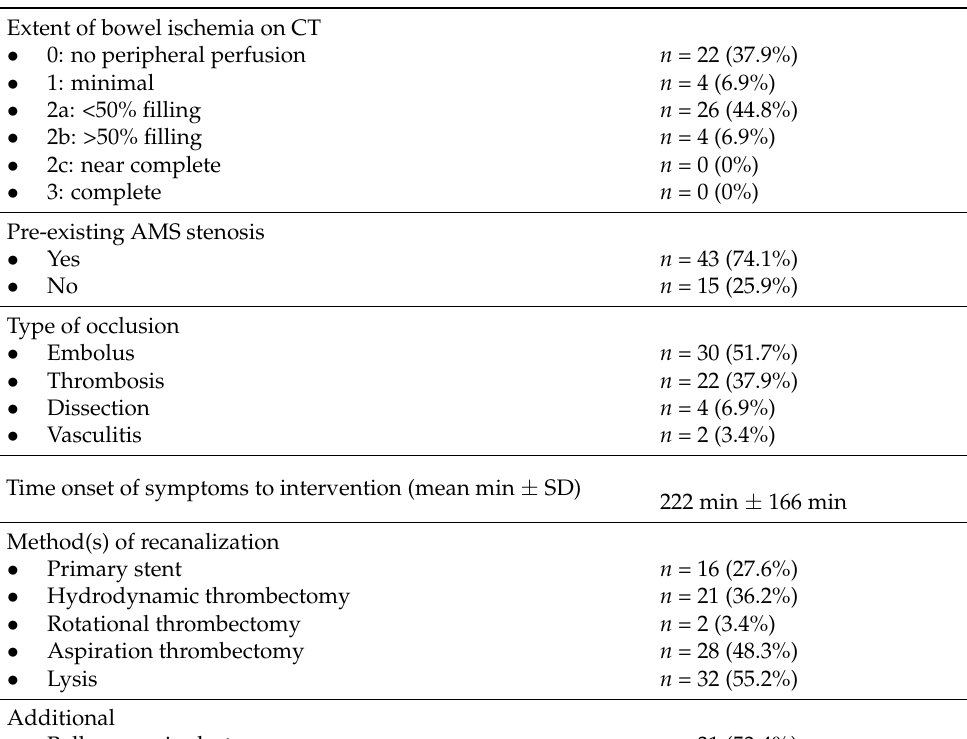
Table 2. Cont. Extent of bowel ischemia on CT